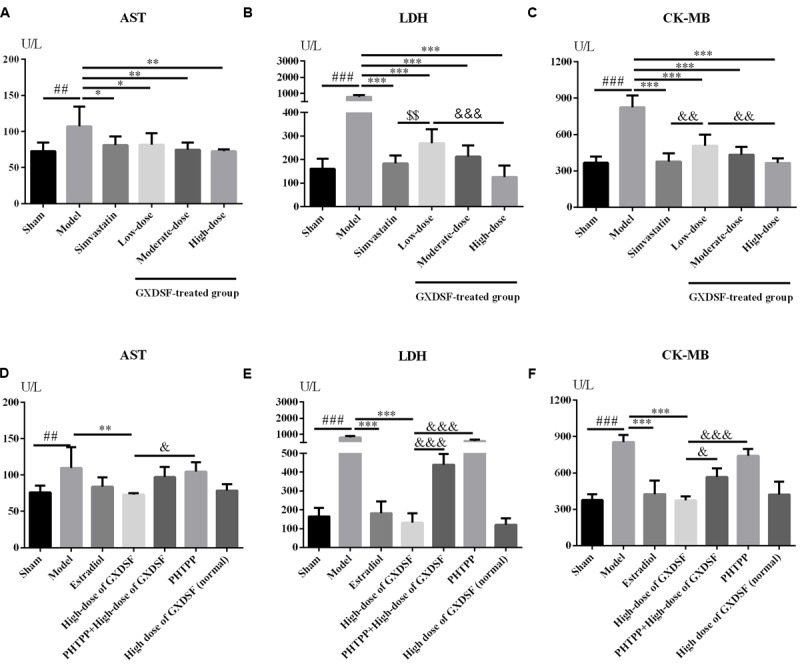
Biochemical parameters, including AST (A,D), LDH (B,E) and CK-MB (C,F), in MIRI-LVR rats treated with different doses of GXDSF and PHTPP. Compared with the sham group: ##P < 0.01, ###P < 0.001. Compared with the MIRI-LVR model group: ∗P < 0.05, ∗∗P < 0.01, ∗∗∗P < 0.001. Compared with the simvastatin group: $$P < 0.01. Compared with the high-dose group: &P < 0.05, &&P < 0.01, &&&P < 0.001. The data are presented as the mean ± SD (n = 10 in each group).